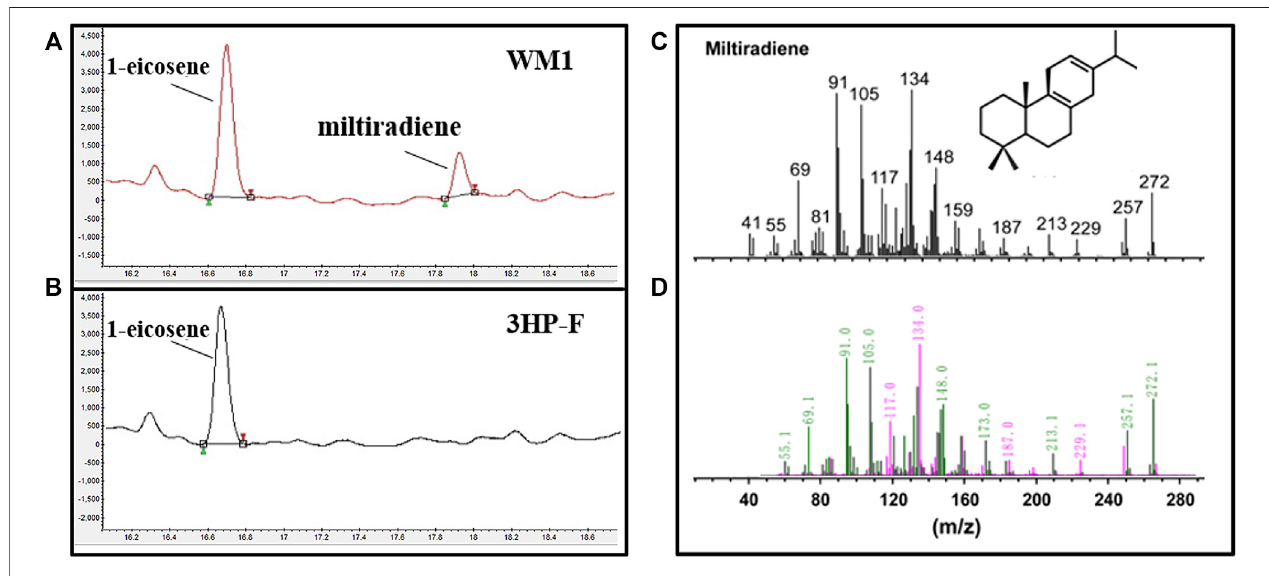
FIGURE2| Miltiradieneproductionin S.cerevisiae . (A) ChromatogramofmiltiradieneproducedbystrainWM1; (B) Chromatogram oftheoriginalstrain3HP-F; (C) GC – MS spectra of miltiradiene published in the literature (Hu et al., 2020); (D) GC – MS spectra of the chromatographic peak at RT = 17.82